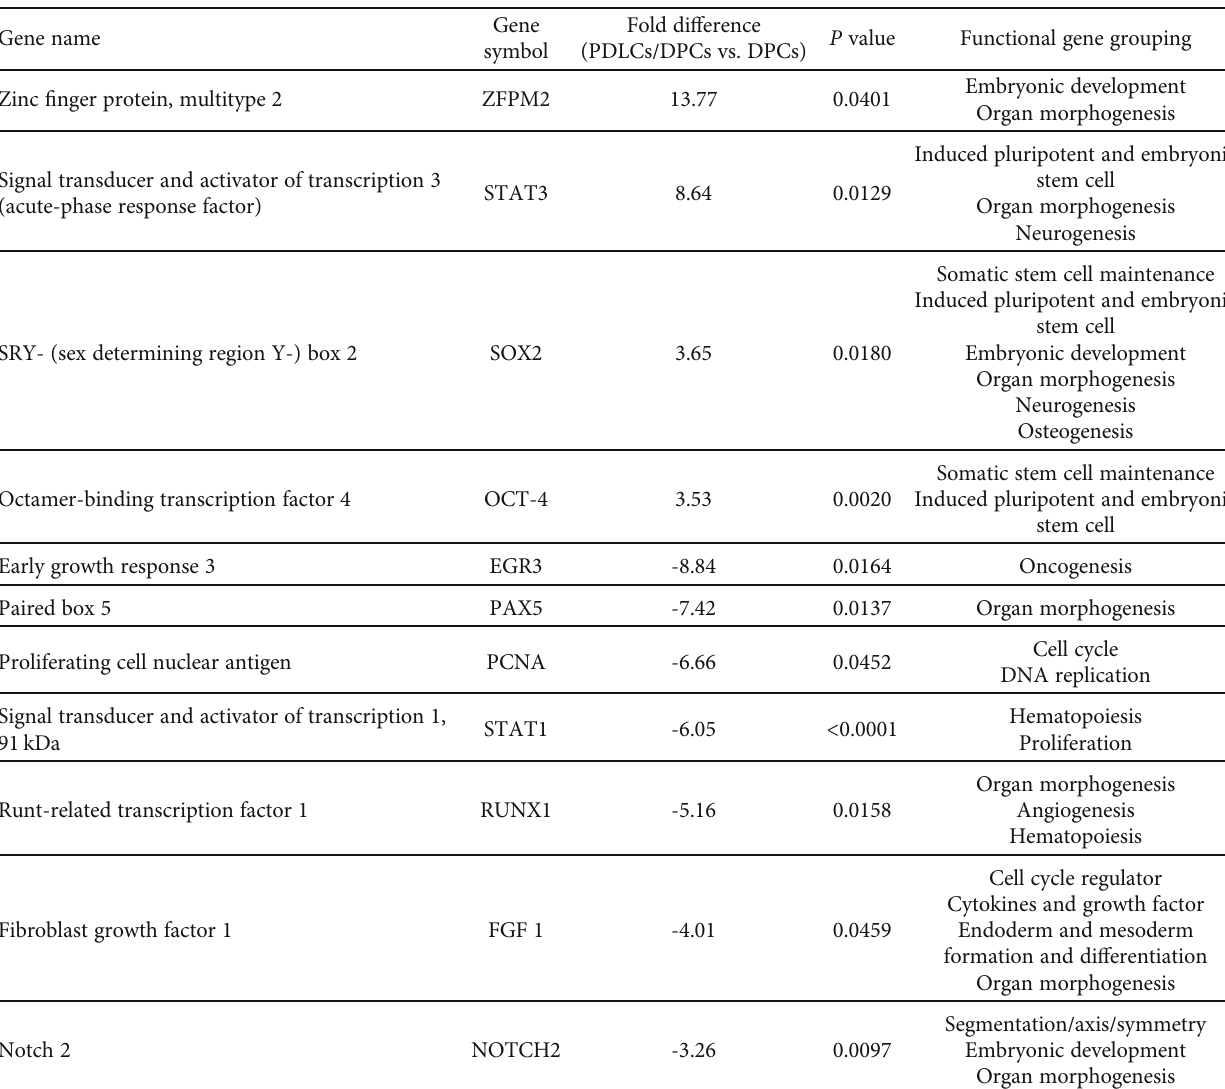
Table 4: List of genes with altered expression with DPCs with indirect